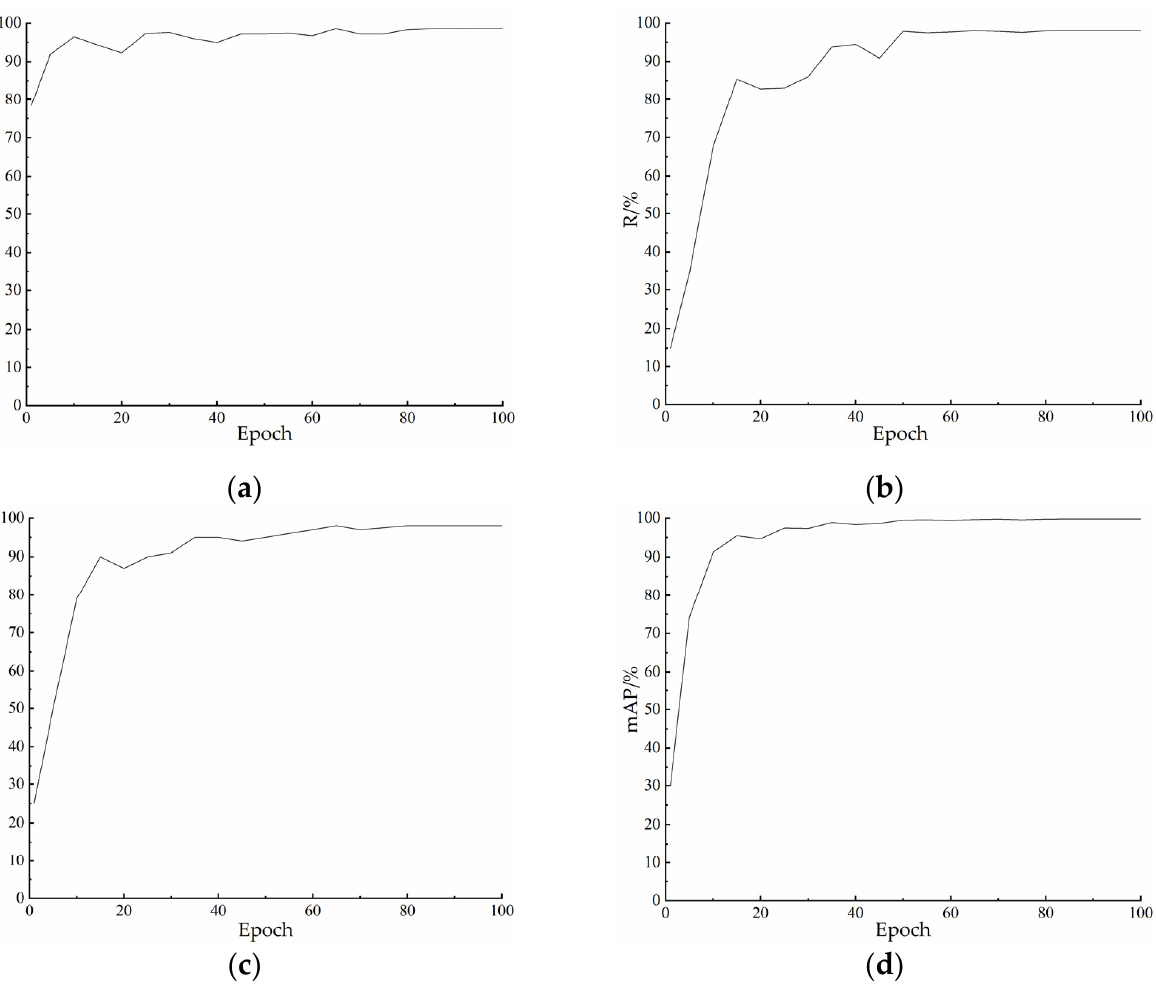
Figure 10. Variation of each index with training times: ( a ) Curve of P value changing with training times; ( b ) Curve of R value changing with training times; ( c ) Curve of F1 value changing with training times; ( d ) Curve of mAP value changing with training times.